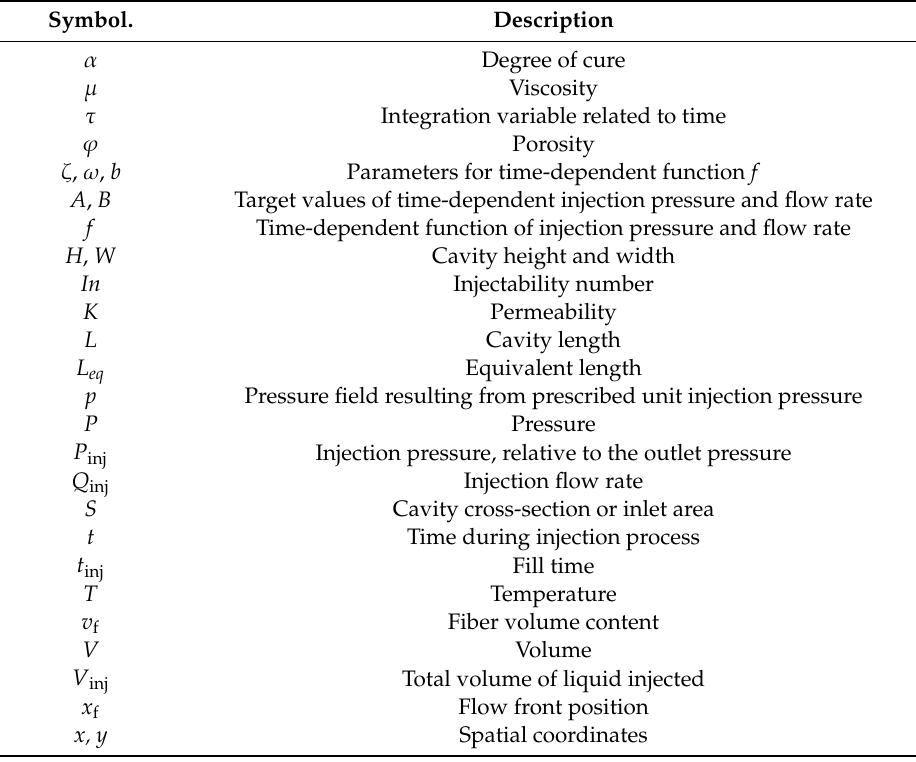
Table 1. List of